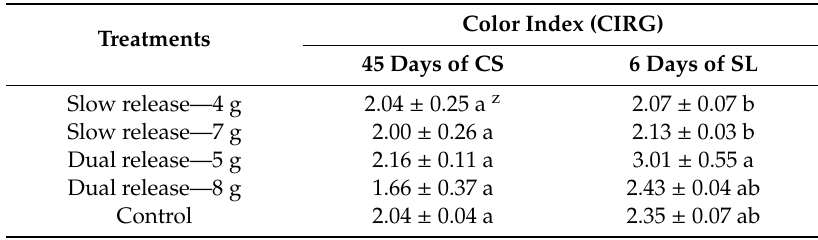
Table 5. Color index (CIRG) of clamshell-packaged ‘BRS Nubia’ seeded table grapes after 45 days of storage in cold storage(CS) at 1 ± 1 ◦ C followed by 6 days at shelf life (SL) at 22 ± 1 ◦ C, packaged with di ff erent SO 2 -generating